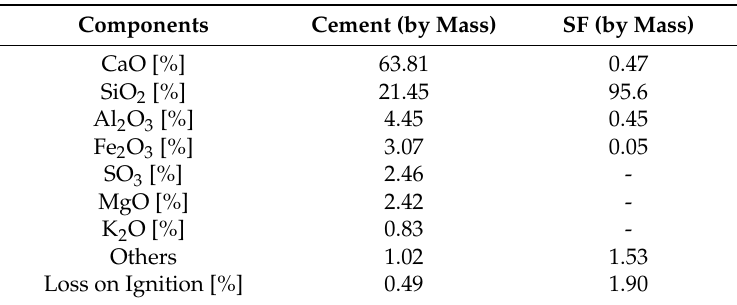
Table 1. Chemical composition of cement and silica fume (SF). Components Cement (by